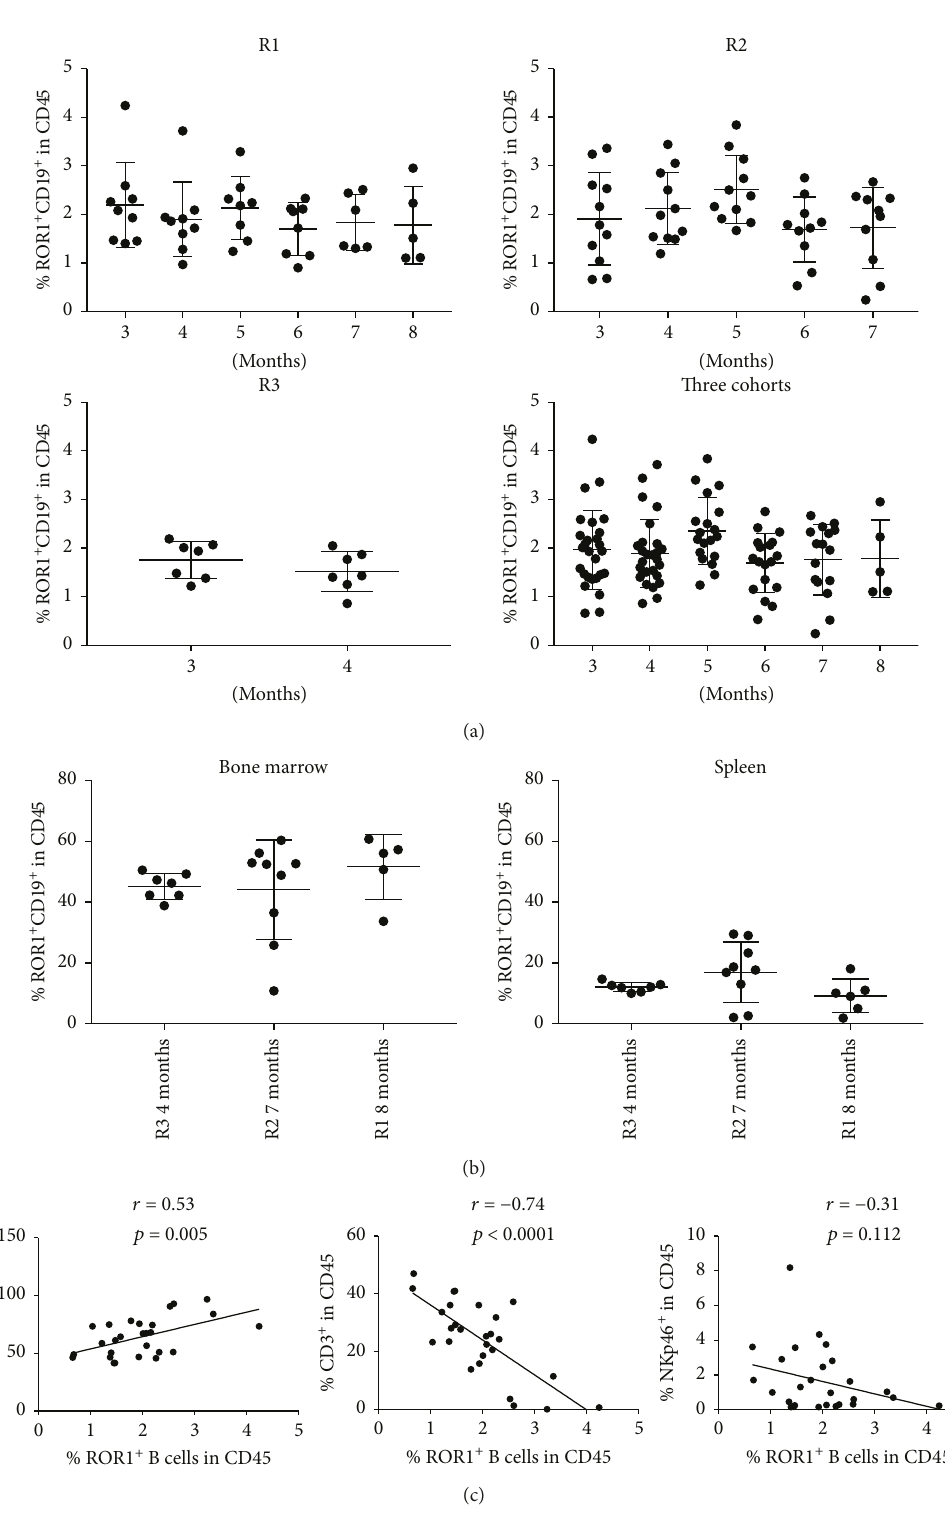
Figure 3: Frequency of ROR1-expressing B cells maintained in huNSG mice. (a) The frequency of ROR1 + B cells within human CD45 + cells in the blood of huNSG mice was analyzed in di ff erent time points after reconstitution. Data from 3 di ff erent cohorts of huNSG mice are shown individually (R1, R2, and R3) and as composite data (three cohorts). (b) Frequency of ROR1 + B cells within human CD45 + cells in the bone marrow (left) and spleen (right) of huNSG mice at di ff erent time points. Horizontal lines represent mean and SD. (c) Correlation of the frequencies of ROR1 + CD19 + cells with the frequencies of human CD19 + B cells, CD3 + T cells, and NKp46 + NK cells in huNSG mice. The Pearson coe ffi cient r is shown, a two-tailed statistical analysis was performed, and the p value is